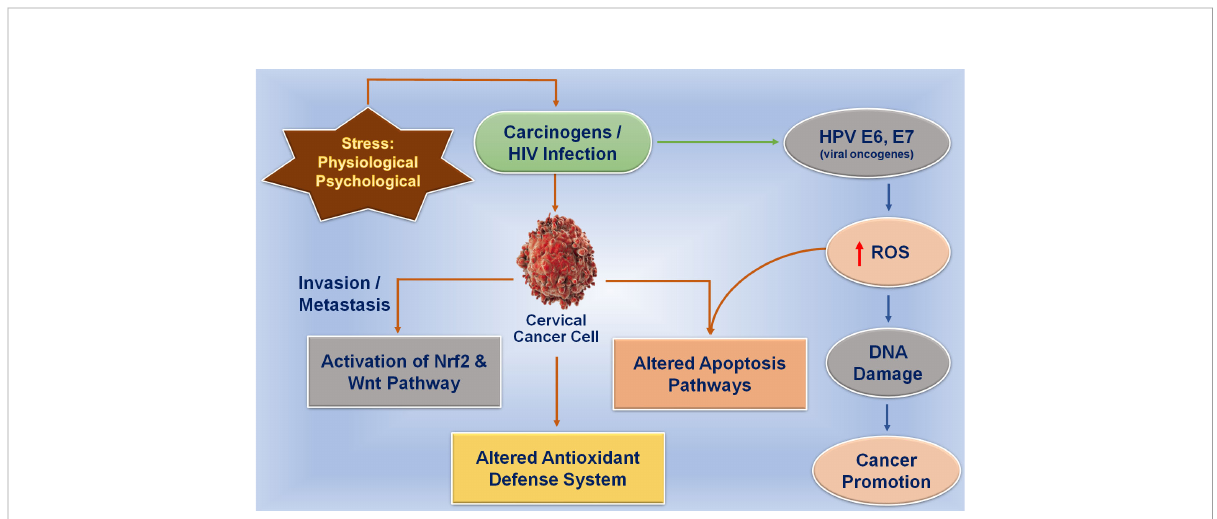
FIGURE 1 Effect of physiological and psychological stress on oxidative stress and viral infection in the cervix region. Physiological and psychological stress directly affects the generation of oxidative stress in tissues that are correlated with the initiation of DNA damage in the cervical epithelium which further promotes tumor